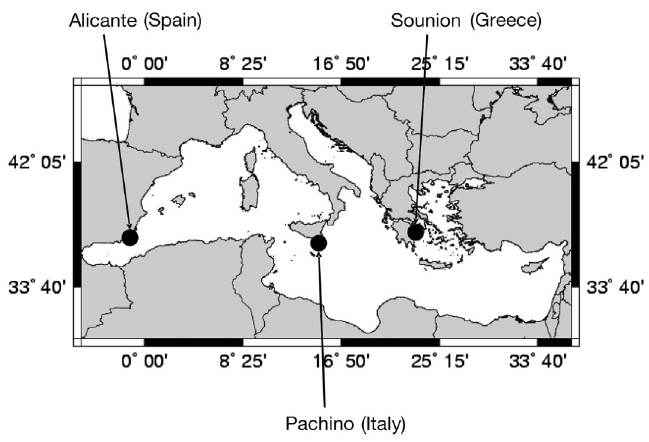
Fig. 1. Sampling areas in the Mediterranean